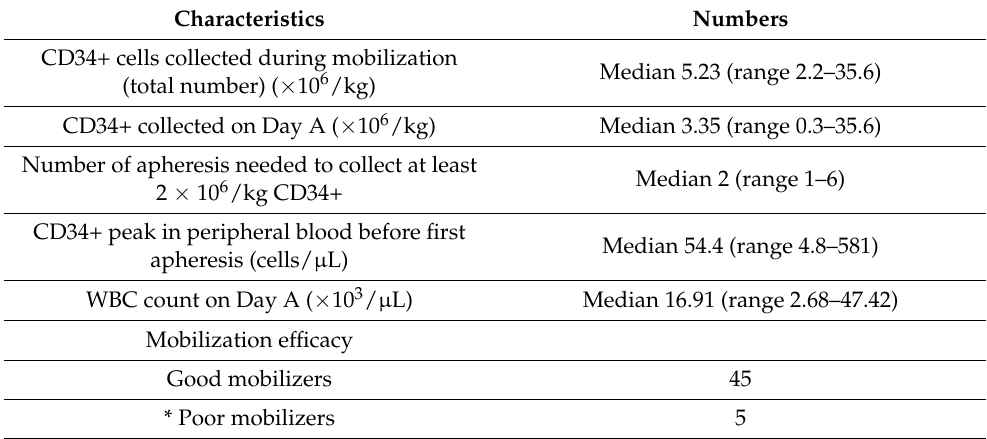
Table 2. Clinical data on hematopoietic stem cell (HSC) mobilization in patients enrolled in the study.